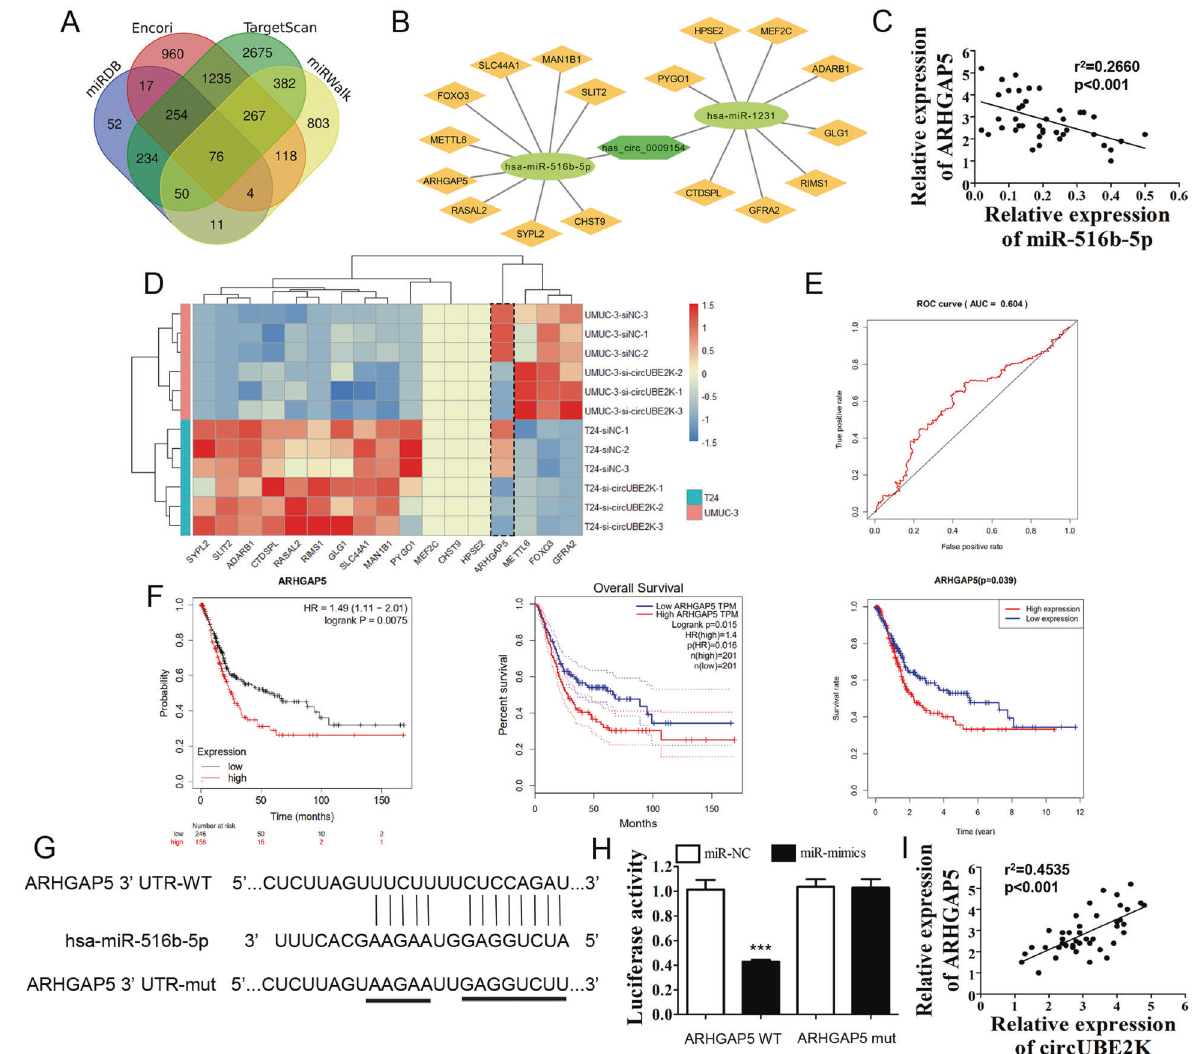
Fig. 4 ARHGAP5 was the down-stream target of miR-516b-5p, and it could predict BC prognosis. A Venn diagram showed potential down- stream targets of miR-516b-5p predicted by miRDB, Encori, TargetScan and miRWalk. B Diagram of ceRNA network showed circUBE2K/miR- 516b-5p/ARHGAP5 axis. C Scatter plot presented negative correlation between expression level of miR-516b-5p and ARHGAP5 in BC tissues ( n = 42, r 2 = 0.2660, P < 0.001). D Potential down-stream gene expression levels were carried out by qRT-PCR. Heatmap illustrated 17 candidate gene expression level in UM-UC-3 and T24 transfected with siNC and si-circUBE2K (Z-Score scaled). E Time-dependent receiver operating characteristic (ROC) curve showed ef fi cacy of ARHGAP5 expression level predicting BC 3-year OS. The area under curve (AUC) was 0.604. F Kaplan – Meier plots for BC patients ’ OS, based on ARHGAP5 expression level (Left: Kaplan-Meier Plotter; Middle: GEPIA; Right: TCGA database). G Binding site of ARHGAP5 3 ′ -UTR and miR-516b-5p was predicted by Interactome. The third row showed mutated ARHGAP5 3 ′ - UTR sequence for further dual-luciferase reporter assay. H Luciferase activity were measured 3 days after co-transfection with ARHGAP5 (ARHGAP5 WT)/mutated ARHGAP5 (ARHGAP5 MUT) and miRNA mimics negative control (miR-NC)/hsa-miR-516b-5p mimics (miR-mimics) in HEK-293T cells. Error bars indicate SD ( *** P < 0.001 vs. vehicle). I Scatter plot presented positive correlation between expression level of circUBE2K and ARHGAP5 in BC tissues ( n = 42, r 2 = 0.4535, P <